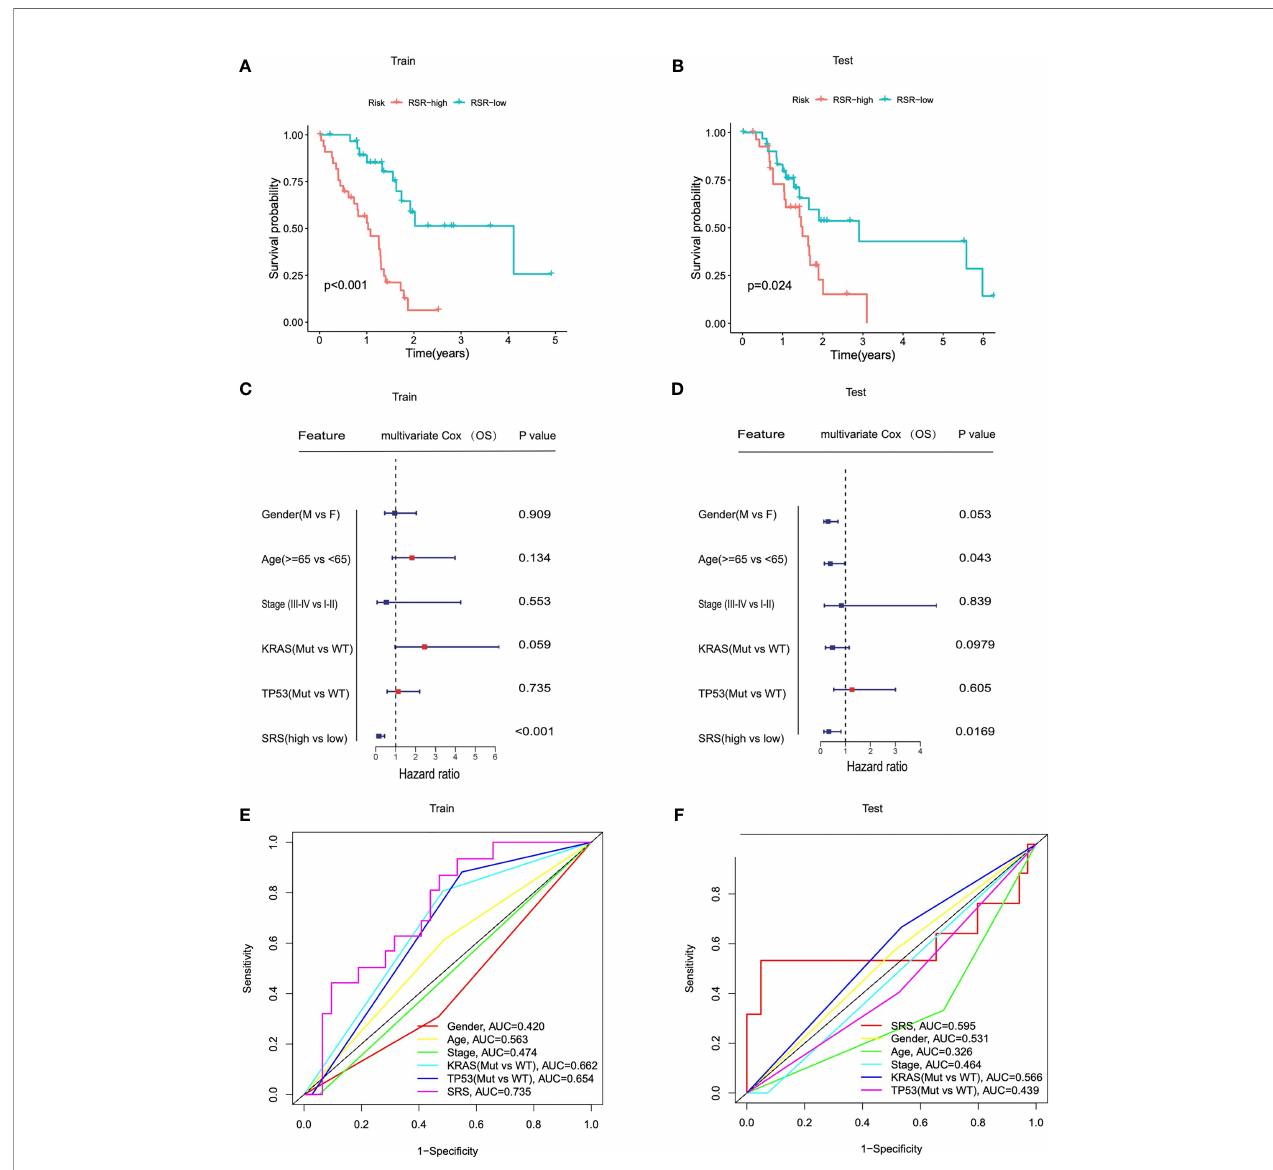
FIGURE 4 | SRS served as a risk factor for overall survival in each cohort. (A, B) Kaplan – Meier analysis showed that patients of SRS-high exhibited worse OS in the TCGA training cohorts and testing cohorts. (C, D) Univariate Cox regression analysis and multivariate Cox regression analysis demonstrated that SRS was the only independent risk factor for OS among all the clinical variables in the TCGA training cohorts and testing cohorts. (E, F) Time-dependent ROC curves of the clinical variables at 3 years between patients at SRS-high and SRS-low in training and testing